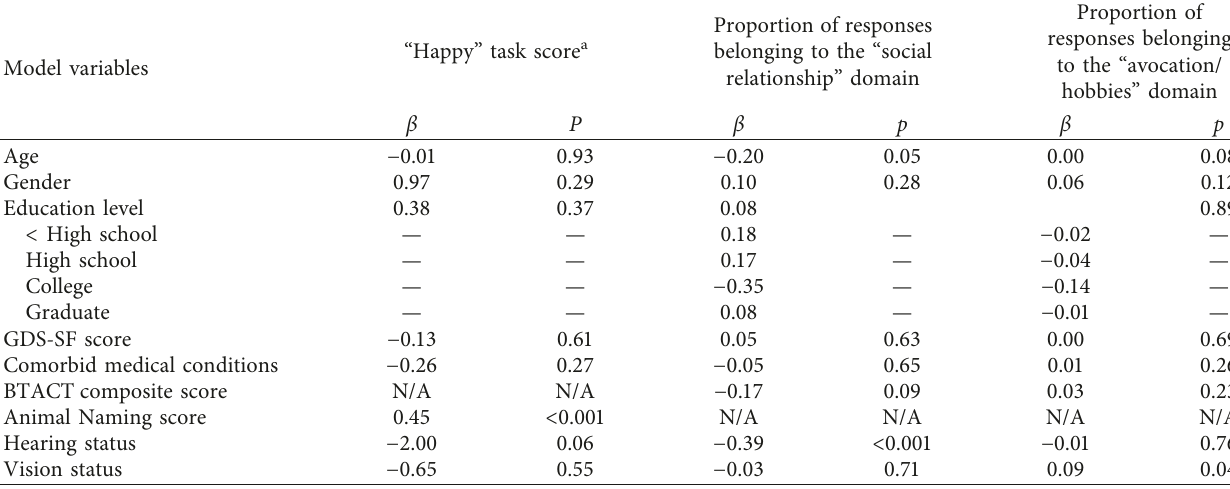
Table 5: Predictors of response patterns: results of multivariate regression models.